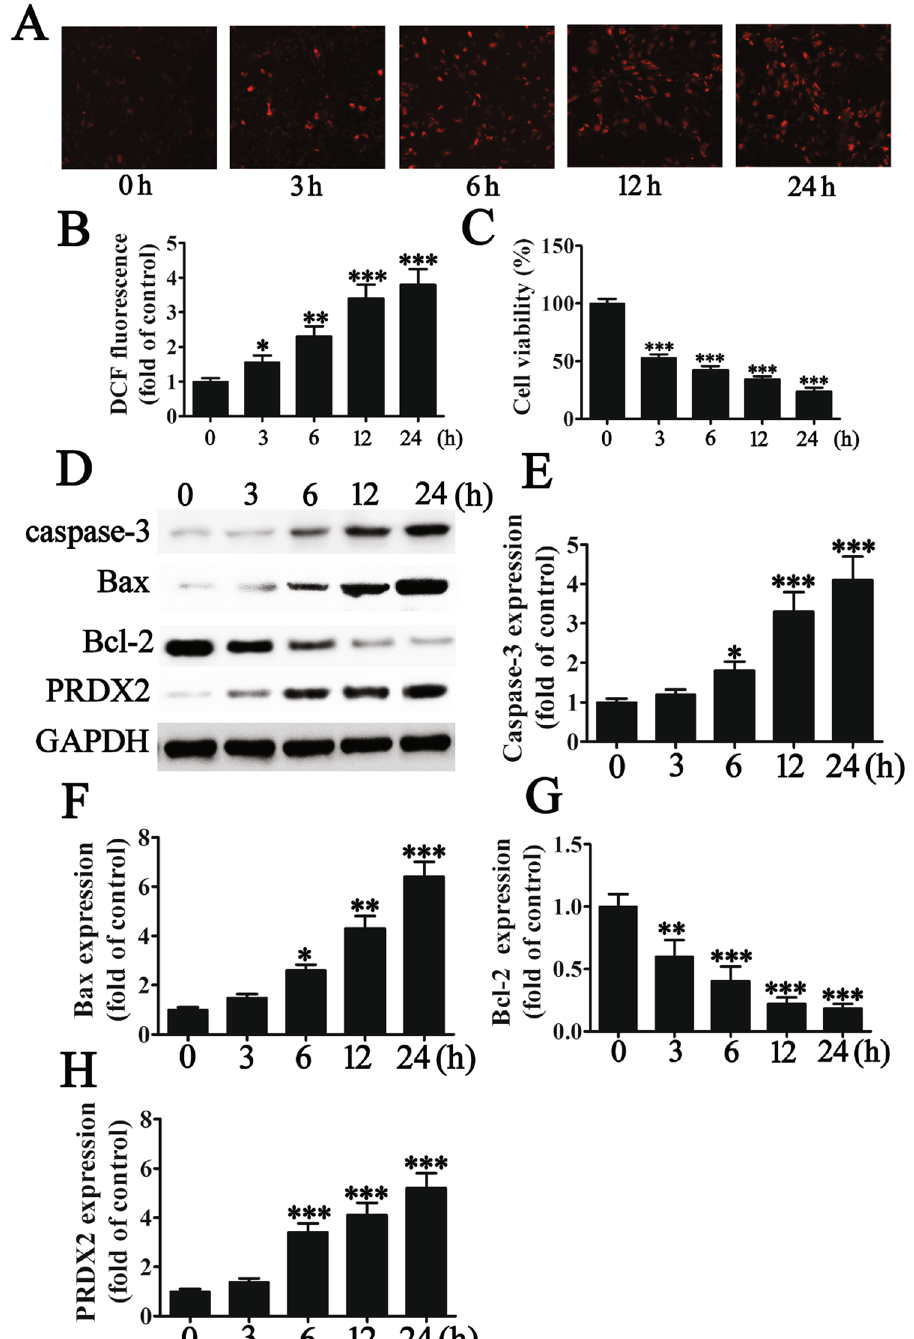
Figure 1. Hypoxia-induced oxidative stress inhibits H9c2 viability and promotes H9c2 apoptosis. H9c2 were exposed to hypoxia conditions for 0, 3, 6, 12 or 24 h before cell activity, ROS production and apoptosis-related protein were measured. ( A and B ) Mitochondrial ROS production in H9c2 cells at different times of hypoxic treatment. The data are presented as means ± SD of the mean from three separate cell experiments. *** p < 0.001 vs control. Magnification 200 × . ( C ) The effects of hypoxia treatment on H9c2 cell viability. The data are presented as means ± SD of the mean from three separate cell experiments. * p < 0.05, ** p < 0.01, *** p < 0.001 vs control. ( D – H ) The expression of apoptosis-related proteins was measured by western blot. GAPDH was used as a loading control. The results show that hypoxia treatment promotes the expression of caspase-3 ( E ) and Bax ( F ) in H9c2 cells but inhibits Bcl-2 expression ( G ). The results also show that hypoxia promotes the expression of PRDX2 which may be related to anti-oxidative stress. The data are presented as means ± SD of the mean from three separate cell experiments. * p < 0.05, ** p < 0.01, *** p < 0.001 vs